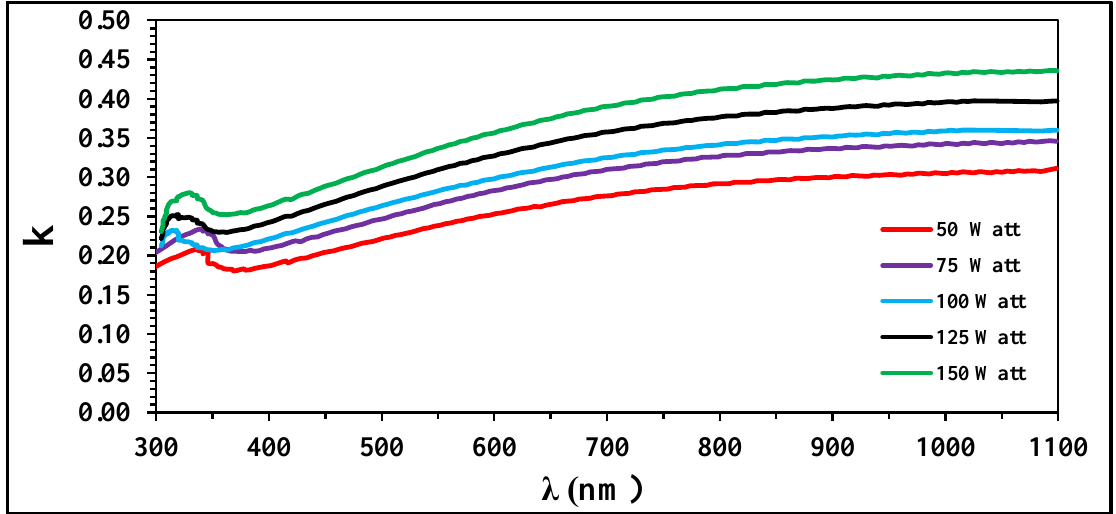
Fig. 5: Extinction coefficient as a function of wavelength for (Ti6Al4V) thin film at different working RF power.